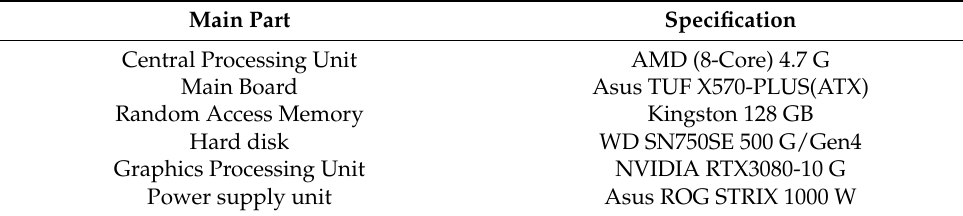
Table 2. The description of the experimental environment.